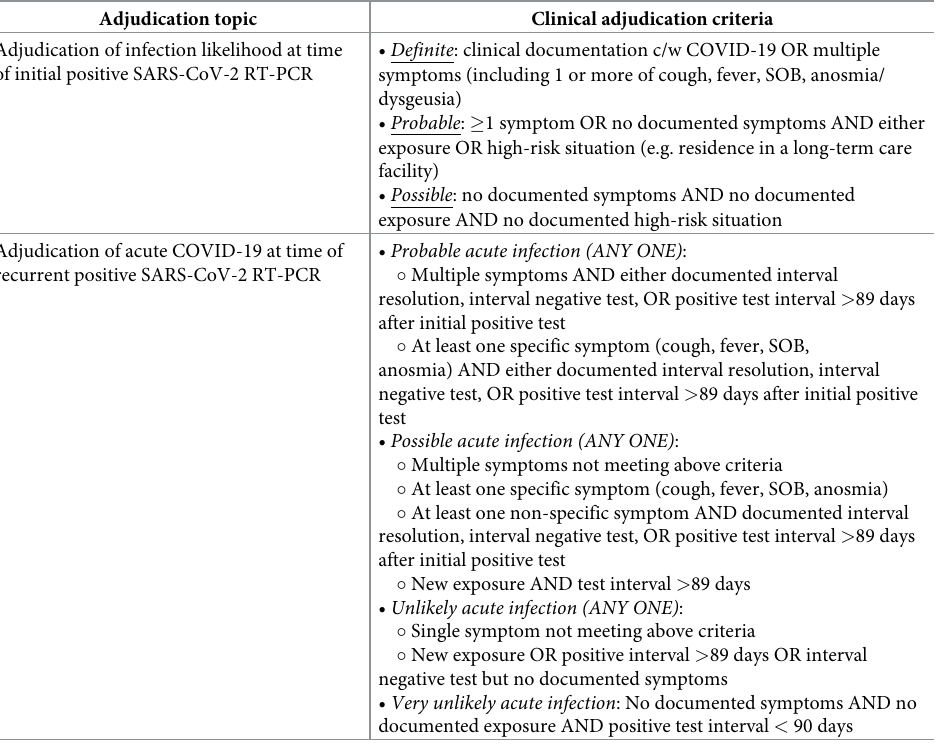
Table 1. SARS-CoV-2 infection likelihood clinical adjudication